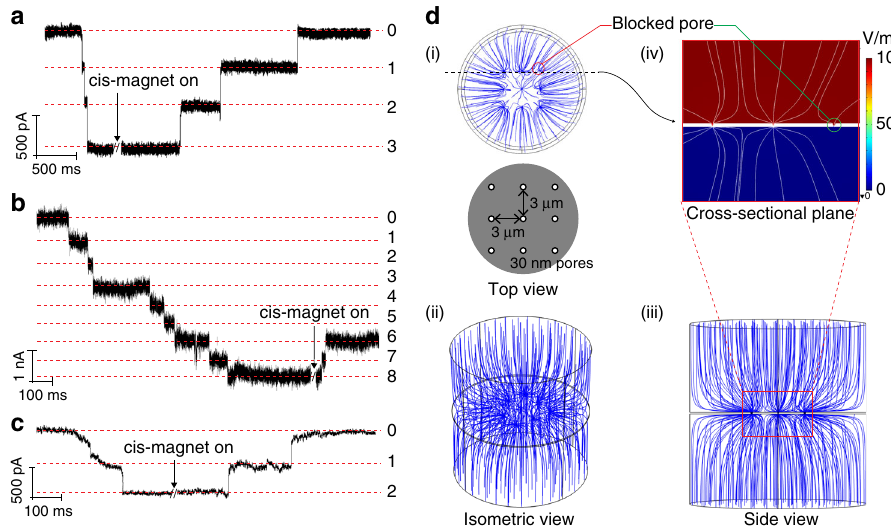
Fig. 4 Paralleled detection of PSA using 3 × 3 nanopore array. Concatenated ionic current traces showing multiple sequential blocking and unblocking events of ( a ) 3 × 3 array of 27 nm nanopores modi fi ed with silane-EG 6 SAM by 50 nm MNPs when there was no PSA present. b 3 × 3 array of 27 nm nanopores modi fi ed with silane-EG 6 SAM by anti-PSA functionalised 50 nm MNPs in the presence of 5 pg mL − 1 PSA. c 3 × 3 array of 27 nm nanopores modi fi ed with silane-EG 6 SAM by anti-PSA functionalised 50 nm MNPs in the presence of 10 pg mL − 1 bovine serum albumin (BSA). All ionic current traces were recorded in 100 mM KCl and 10 mM Tris pH 7.4 at a potential bias of 100 mV, low-pass- fi ltered at 10 kHz and sampled at 250kHz. ( d ) Simulation of the 3 × 3 array of 30 nm nanopores separated by 3 μ m apart from each other. The simulation region consists of a cylindrical volume of 20 μ m in diameter and 20.18 μ m in height representing the electrolyte medium. A potential bias of + 100 mV was applied from the top boundary whereas the bottom boundary was de fi ned as grounded (0 mV). (i) Top, (ii) isometric, (iii) side view of 3D plots of electric fi eld lines with one nanopore blocked by a 50 nm MNP. Black solid lines represent the interface boundaries whereas blue solid lines denote the simulated electric fi eld lines. (iv) 2D cross-sectional plot of electrical potential and fi eld lines of 3 nanopores (two unblocked and one blocked) as a colour map and white solid lines respectively. SiN membranes of a thickness of 180 nm were employed here for the paralleled detection and simulation